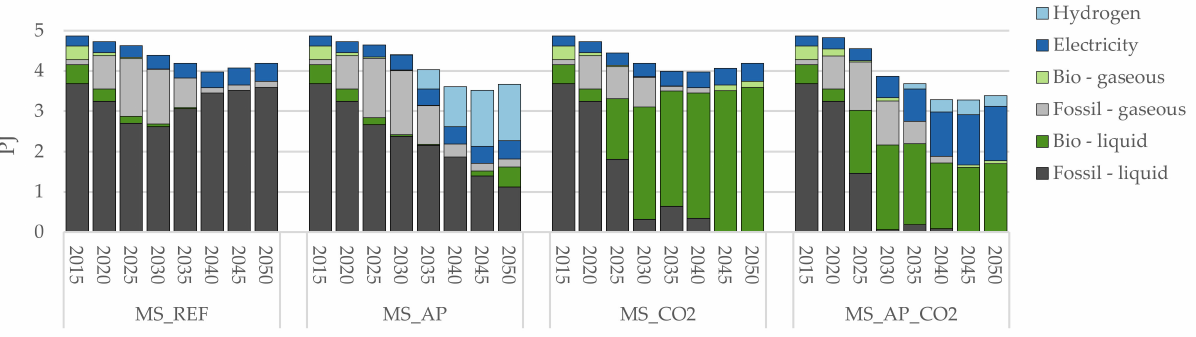
Figure A5. Total final-energy consumption by different fuel types in the mode shift (MS) scenarios